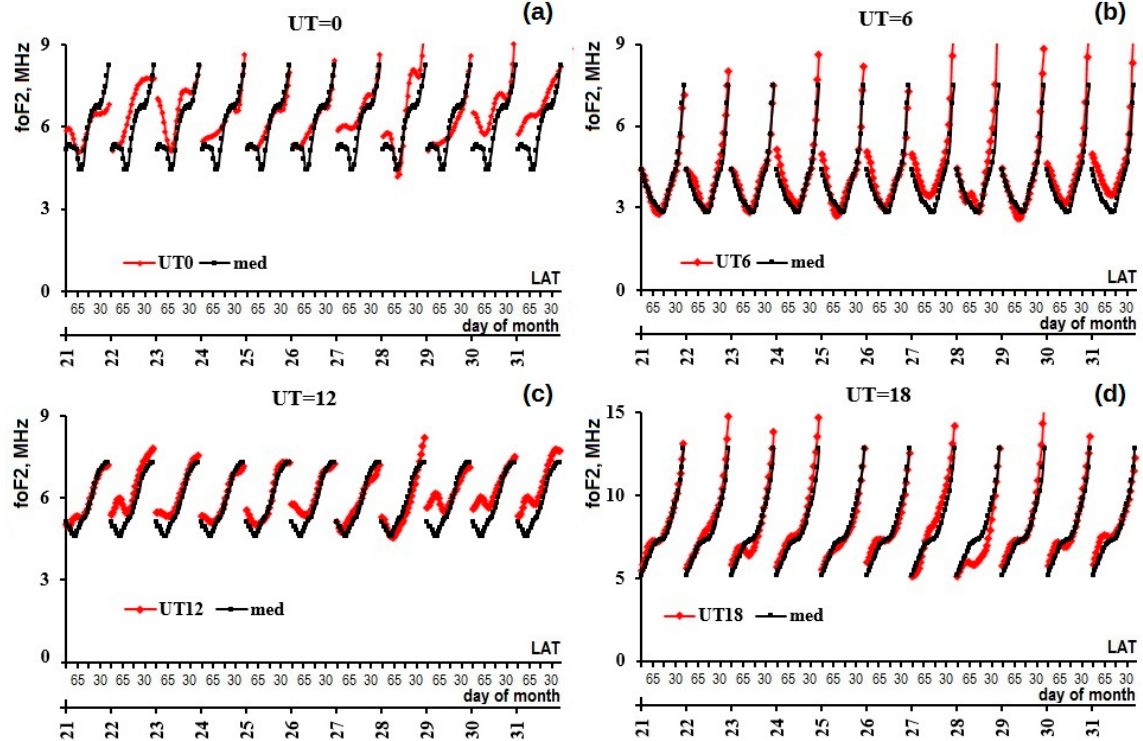
Figure 11. The same as in Figure 10 but during 21–31 March 2012. To sum up, the foF2(rec) latitudinal variations along the considered sector for two 11-day periods were significantly different during the storms of these periods.